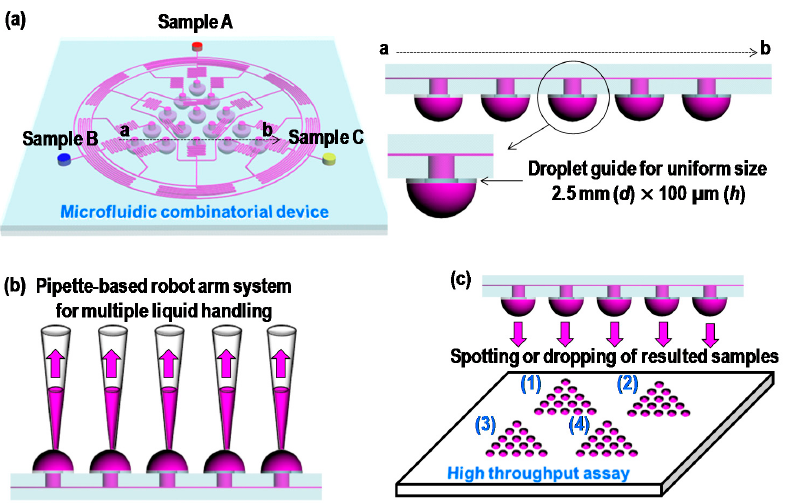
Figure 3. Potential liquid-handling methods using proposed microfluidic combinatorial device. ( a ) Cross-sectional view of proposed device for detailed design parameter for liquid handling. ( b ) Bottom–up method and ( c ) top–down method.